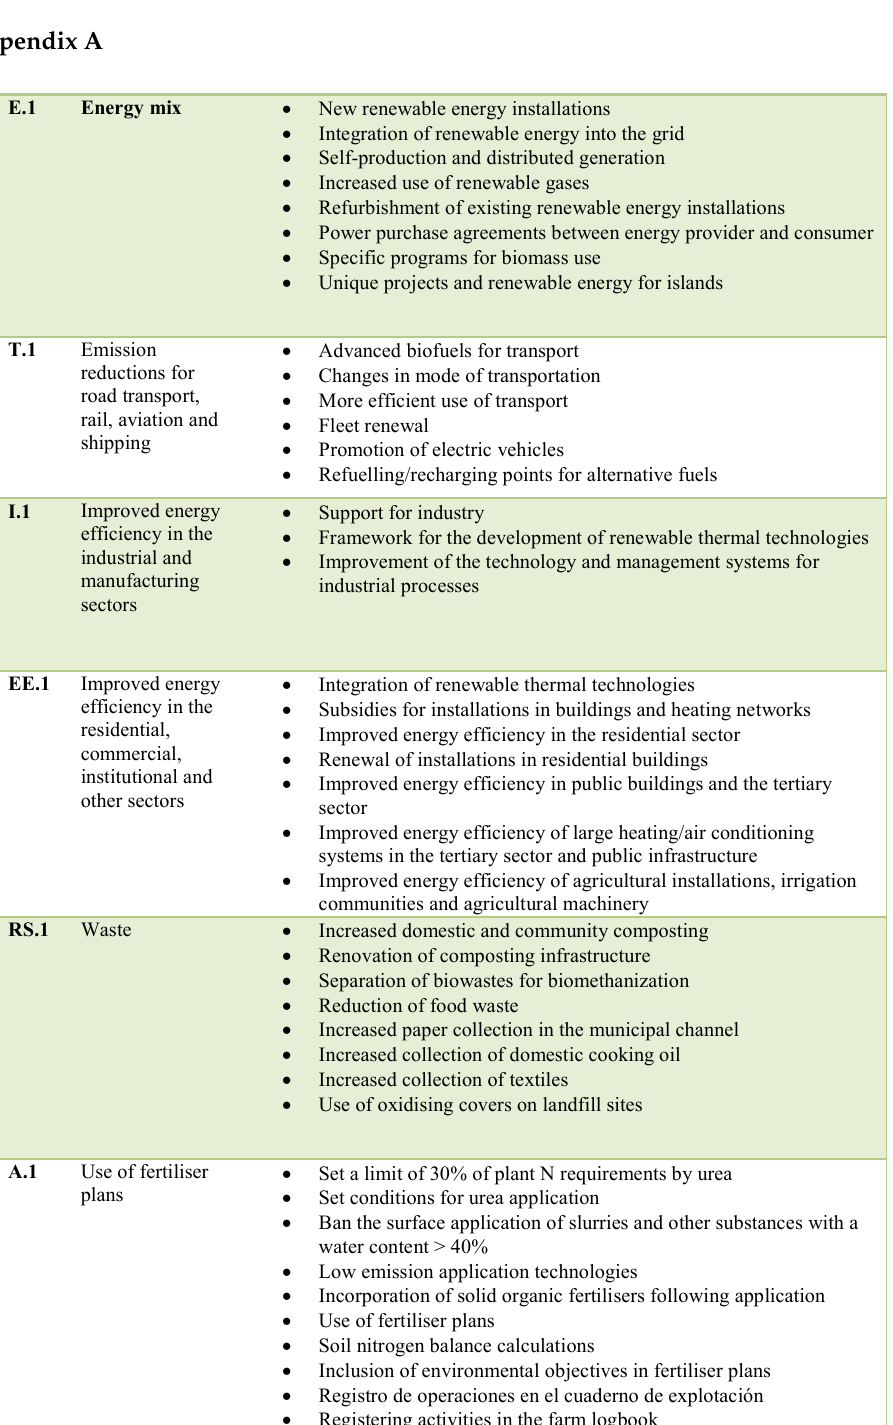
Figure A1 . Measures Included in the WAM2030 scenario. Figure A1. Measures Included in the WAM2030